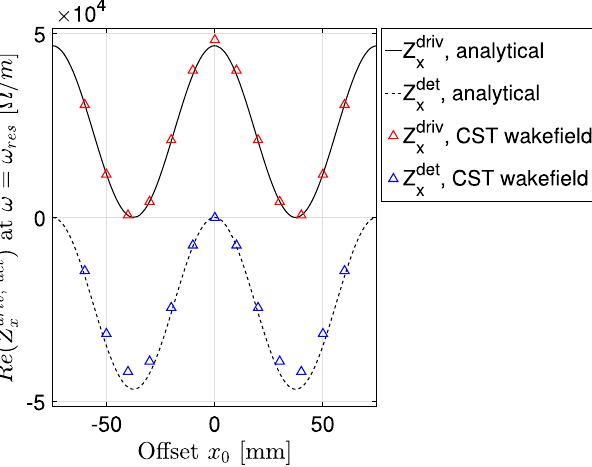
FIG. 3. Driving and detuning impedances obtained by the CST wakefield simulations, compared to the derived analytical